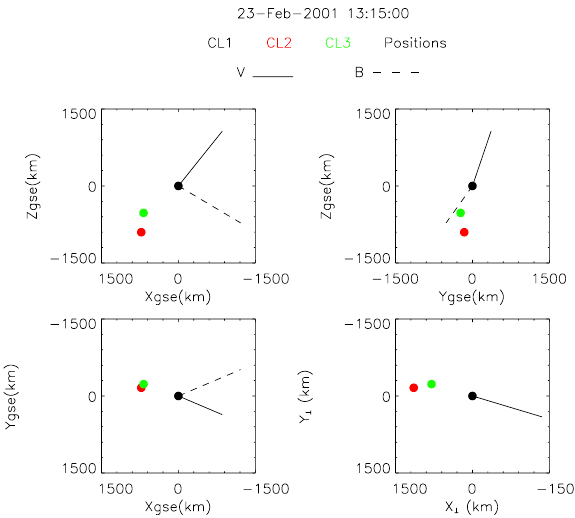
Fig. 6. Relative positions of spacecraft 1, 2 and 3 at the time of crossing into the intense 1keV electron population of the southern plasma sheet on 23 February. Positions with respect to spacecraft 1 are represented by dots using the standard color assignments. Three panels show projections in the 3 principle GSE coordinate system planes. The lower right panel is the projection in the plane perpen- dicular to the magnetic field. + X ⊥ is the direction closest to the Sun in this plane. The spacecraft velocity vector is shown by the solid line, scaled so that 5km/s corresponds to a value of 1500 on the km scale. The magnetic field unit vector projection is given by the dashed